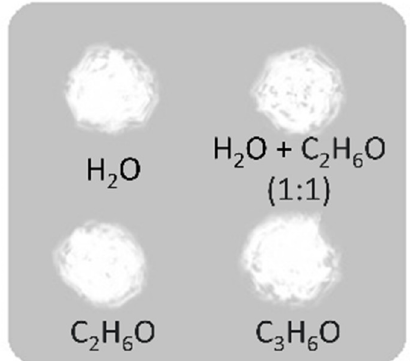
Figure 1. Representation of the order and position in which the solvents were tested in the sample cleaning study. cleaning study.